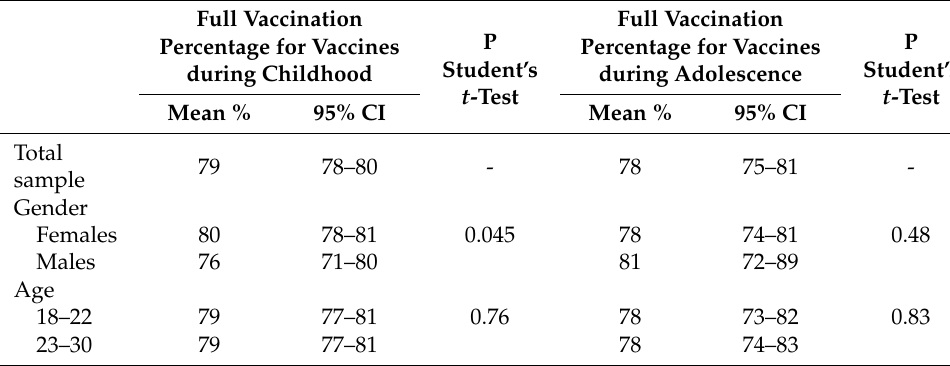
Table 3. Full vaccination percentage regarding vaccines during childhood and during adolescence, in total sample and by their